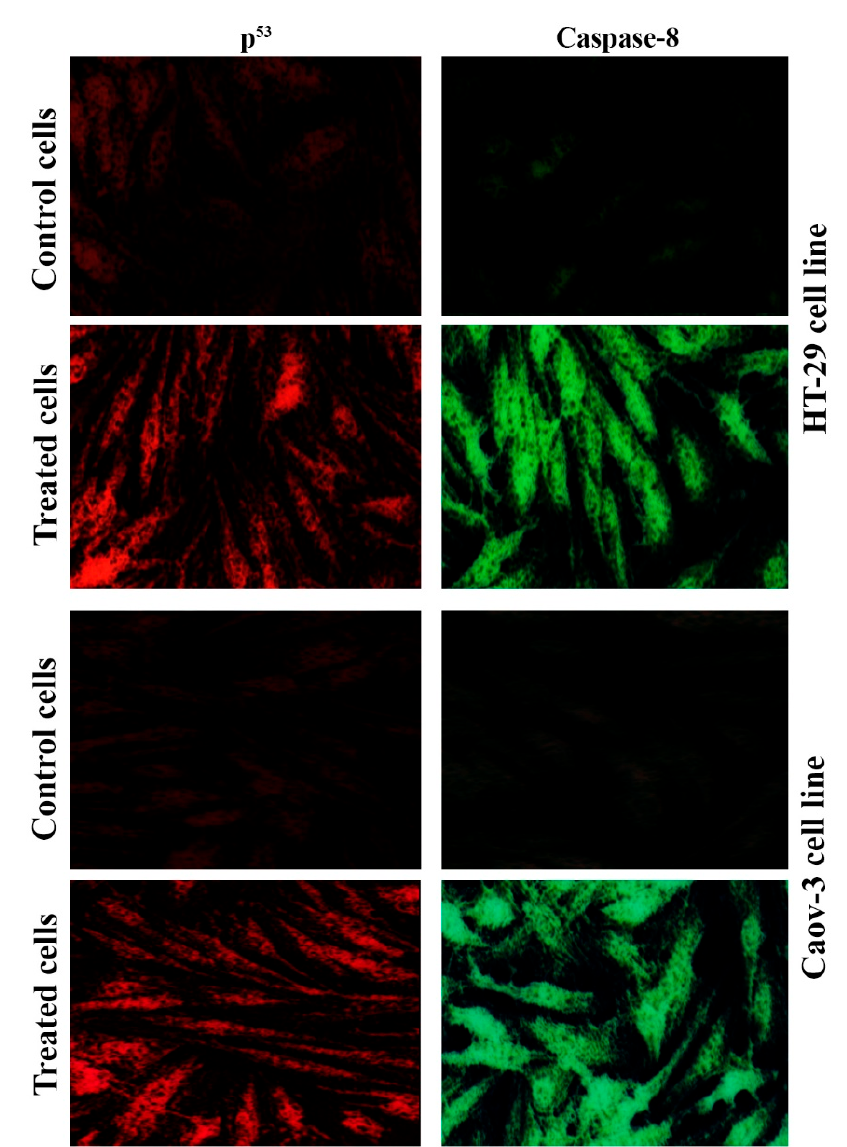
Figure 8. Cisplatin induces apoptosis through p53 and Caspase-8 pathway. Immunofluorescence results of p53 and Caspase-8. Cells were untreated (control), or treated with cisplatin as indicated. Cells were fixed, permeabilized, and then stained with primary and secondary antibodies. Scale bar 10 μ